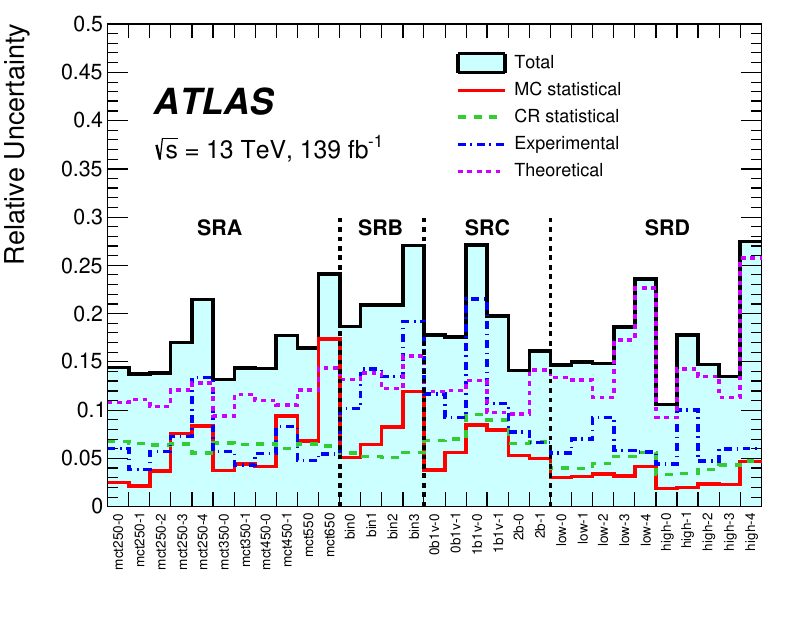
Figure 2 . Summary of the post-fit relative systematic uncertainties of the various signal region yields, also split by